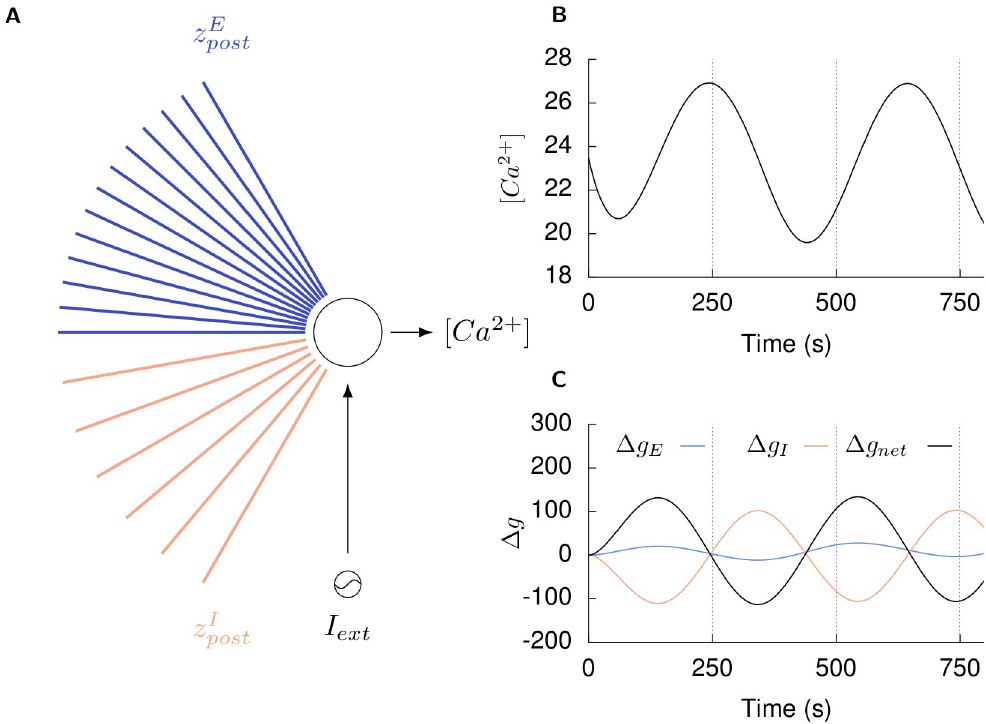
Fig 10. Single neuron simulations show the homeostatic effect of the post-synaptic growth rules. (A) A neuron in its balanced state receives excitatory ( g E ) and inhibitory ( g I ) conductance inputs through its excitatory ( z E ( z I ) dendritic elements, respectively, such that its activity ([ Ca 2+ ]) is maintained at its optimal level ( ψ ) by its net input post conductance ( g net ). (B) An external sinusoidal current stimulus ( I ext ) is applied to the neuron to vary its activity from the optimal level. (C) Under the action of our post-synaptic growth curves, the neuron modifies its dendritic elements to change its excitatory ( Δ g E ) and inhibitory ( Δ g I ) conductance inputs such that the net change in its input conductance ( Δ g net ) counteracts the change in its activity: an increase in [ Ca 2+ ] due to the external stimulus is followed by a decrease in net input conductance received through the post-synaptic elements and vice versa (dashed lines in B and